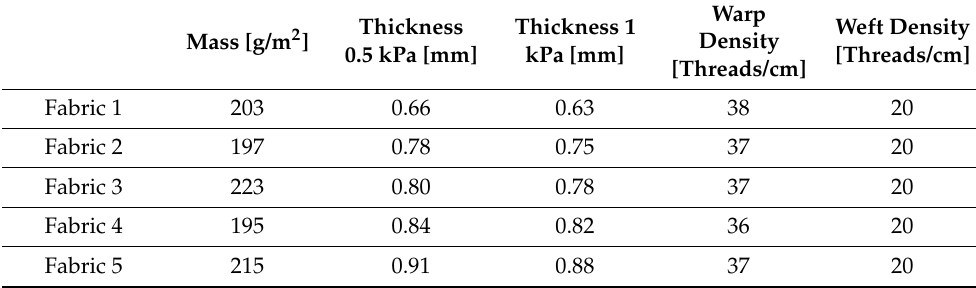
Table 2. Constructional and mechanical characteristics of